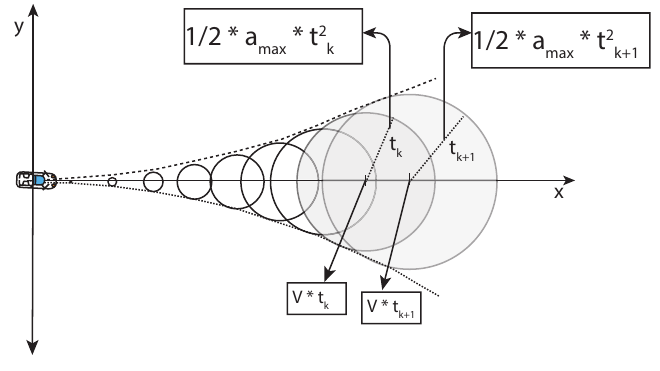
Figure 8. Kamm’s circle.